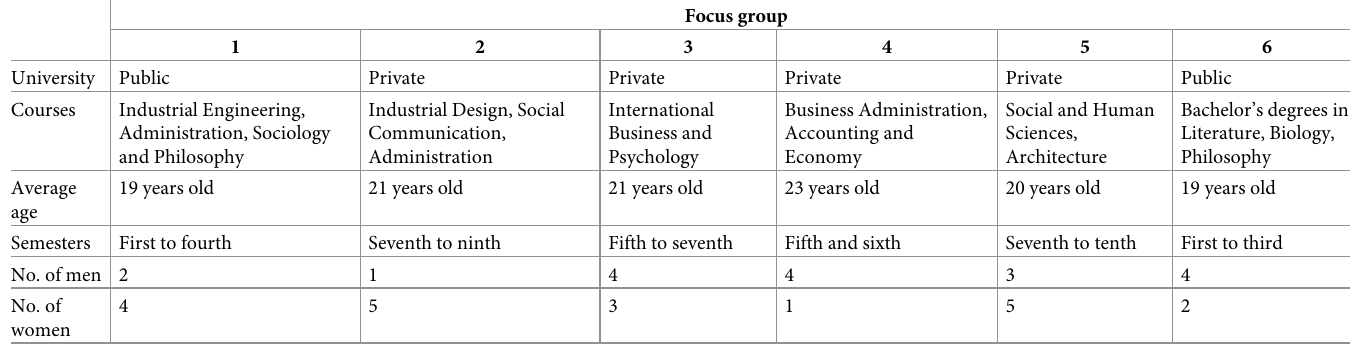
Table 1. Focus groups’